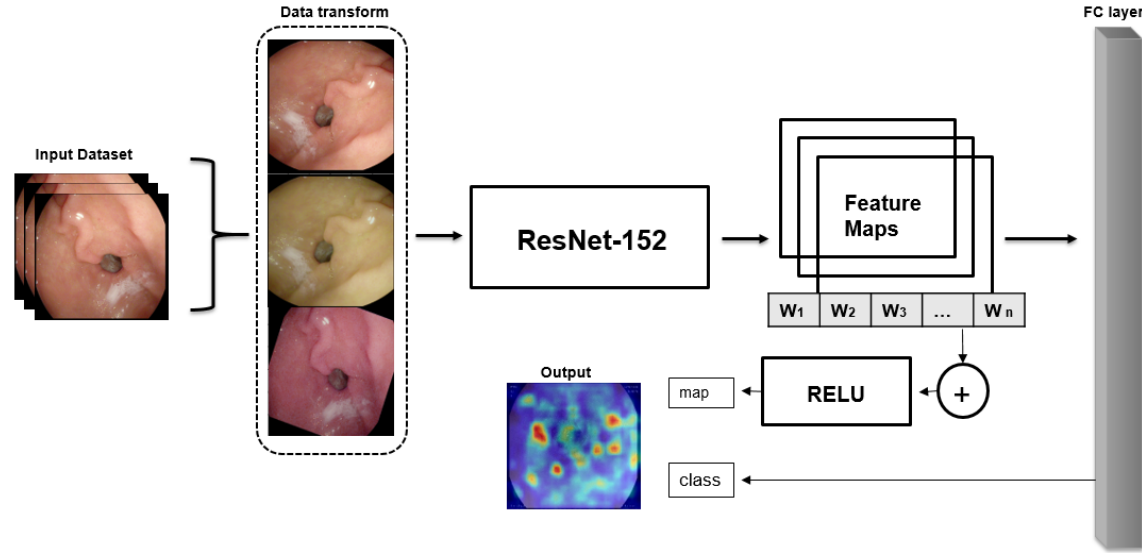
Figure 1. Overall architecture of the explainable AI for the classification of endoscopic images.